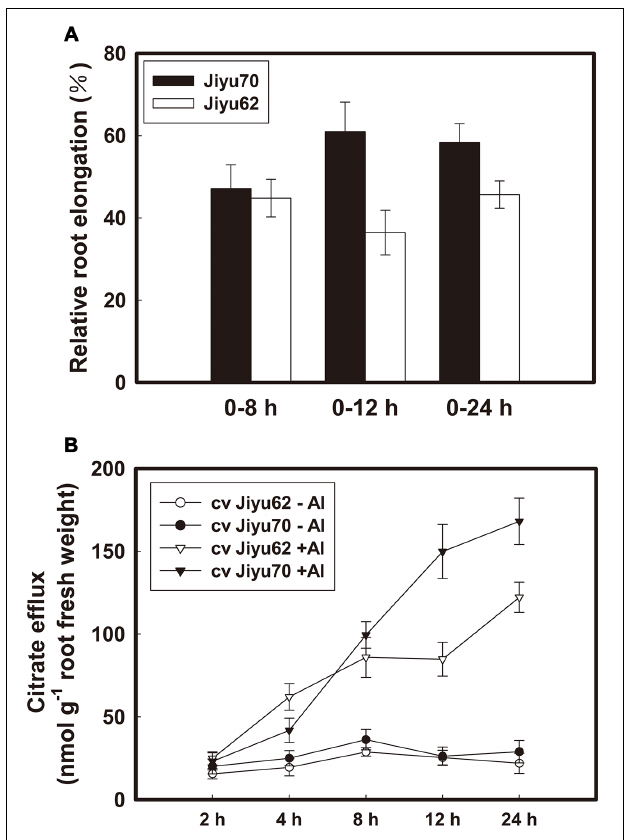
FIGURE 1 | Effect of Al on root elongation (A) and Al-induced citrate efflux (B) of two soybean genotypes. Seedlings with roots 4–5 cm long were exposed to 0 or 30 µ M Al in 0.5 mM CaCl 2 solution. The root length was measured with a ruler at 0, 8, 12, and 24 h. Fourteen-day-old seedlings were exposed to 0 or 30 µ M Al in 0.5 mM CaCl 2 solution. Root exudates were collected at 2, 4, 8, 12, and 24 h. Relative root elongation was calculated, and organic acid exudates were analyzed as described in Section “Materials and Methods.” The values are the means of three independent experiments ± SDs.